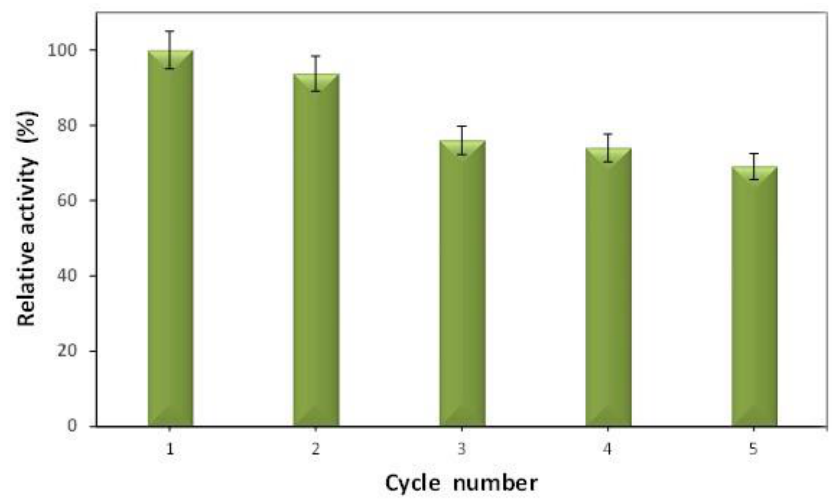
Figure 9. Operational stability of the immobilized biocatalyst.